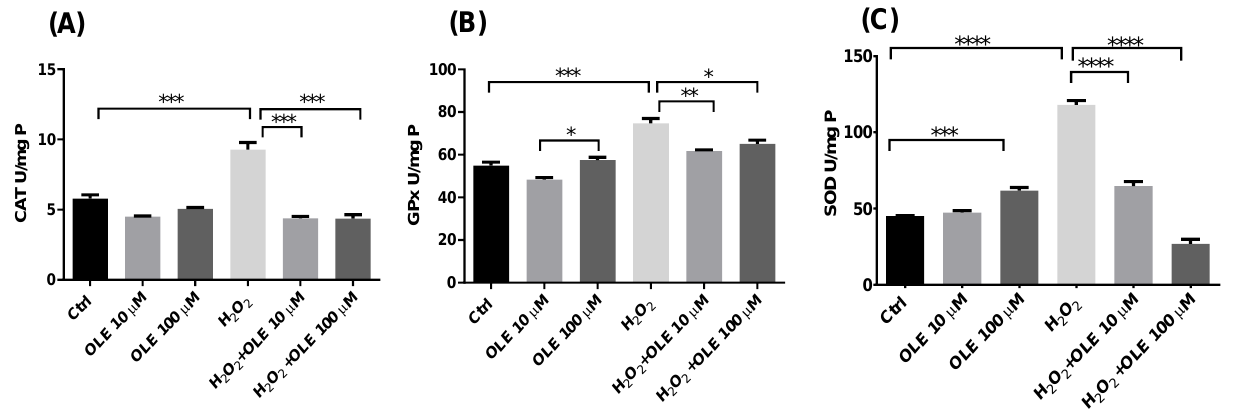
Figure 4. The effect of oleuropein (OLE) on activity of antioxidant enzymes in H 2 O 2 -exposed HTR-8/SVneo cells. The investigated parameters include catalase (CAT) activity ( A ), gluthatione peroxidase (GPx) activity ( B ) and superoxide dismutase (SOD) activity ( C ). The data are expressed as mean + SEM. * p < 0.05, ** p < 0.01, *** p < 0.001, **** p < 0.0001.